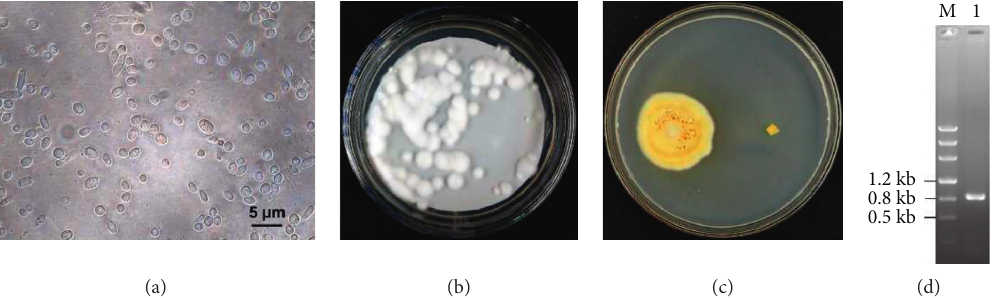
Figure 4: Functional verification of the bar gene in C. militaris . (a) Conidia of C. militaris . (b) Colonies of C. militaris on the selective medium containing 300 μ g/mL glufosinate ammonium and 300 μ g/mL cefotaxime. (c) A C. militaris transformant (left) and a wild-type C. militaris (right) were inoculated on the PDA medium containing glufosinate ammonium (300 μ g/mL) and cultured at 25 ° C for 18 days (including 12 days under dark conditions and 6 days under light conditions). (d) PCR amplification of the bar gene from a randomly selected C. militaris transformant. M:DNA marker; lane 1: 836bp fragment of the bar gene expression cassette.